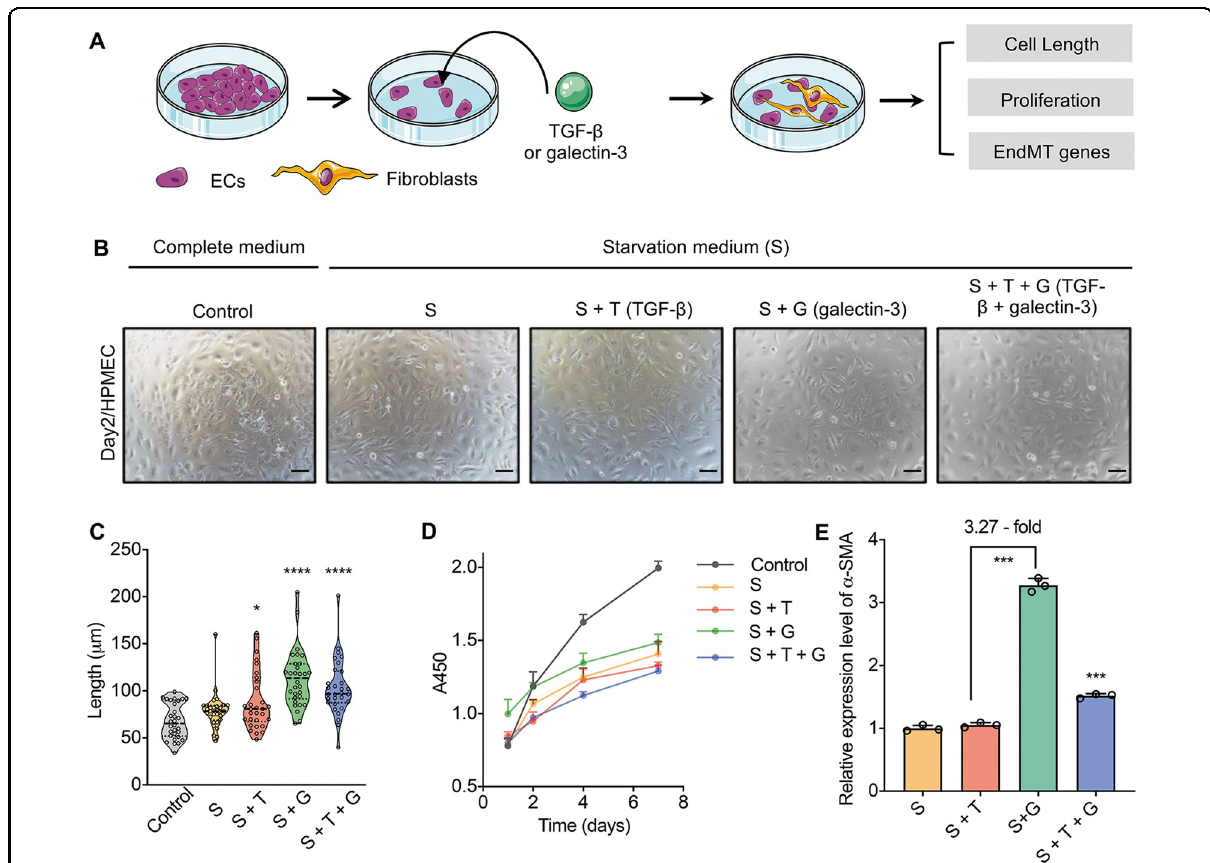
Fig. 5 Galectin-3 promotes the EndMT process in vitro. A Schematic diagram showing the exploration of the potential of galectin-3 in inducing EndMT in vitro using HPMECs. B Morphological changes of HPMECs under different conditions. Complete medium (control): DMEM containing 10% FBS; starvation medium (S): DMEM containing 1% FBS; T: supplemented with 10 ng/ml TGF- β ; G: supplemented with 1 μ g/ml galectin-3. Scale bar